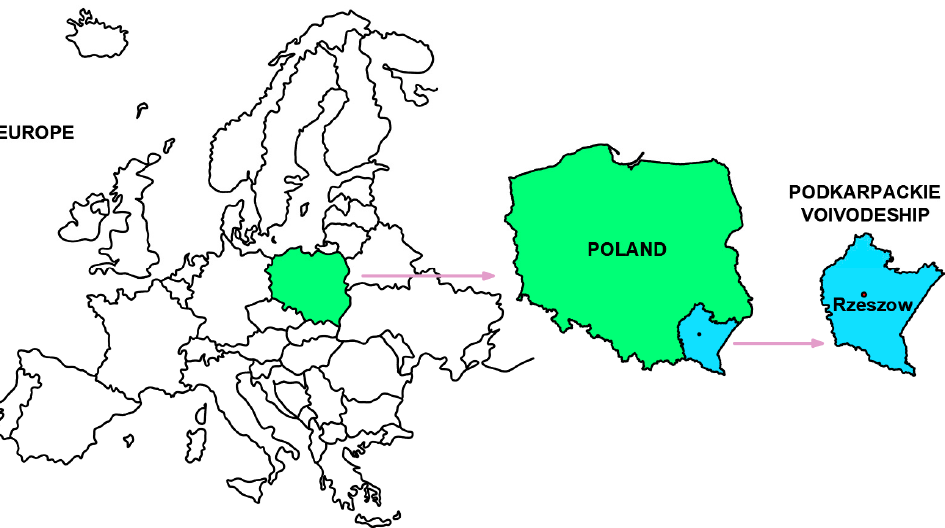
Figure 1. Location of the Podkarpackie Voivodeship on the map of Europe.